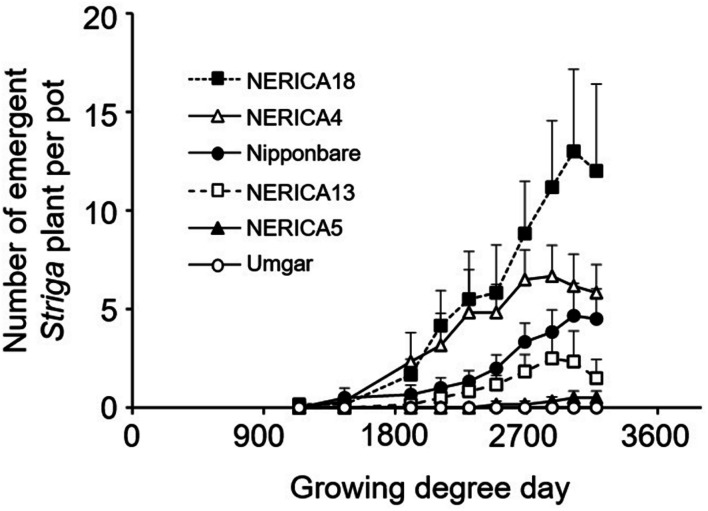
Number of emergent S. hermonthica plants per pot planted with rice. Umgar, NERICA5, NERICA13, Nipponbare, NERICA4, and NERICA18 were used in the second pot experiment. The Striga seeds (16 mg) were mixed into top 5 cm of soil in each pot. Bars indicate standard errors of each mean value of six replications.